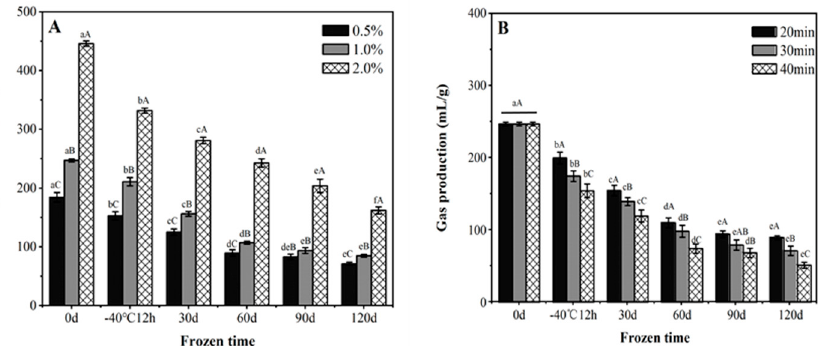
Figure 5. The effect of frozen storage on the gas production capacity of unfermented ( A ) and pre-fermented ( B ) frozen dough. Data with different lowercase and uppercase letters indicate the significant differences among the frozen doughs with different storage times and different processing variables, respectively ( p < 0.05).